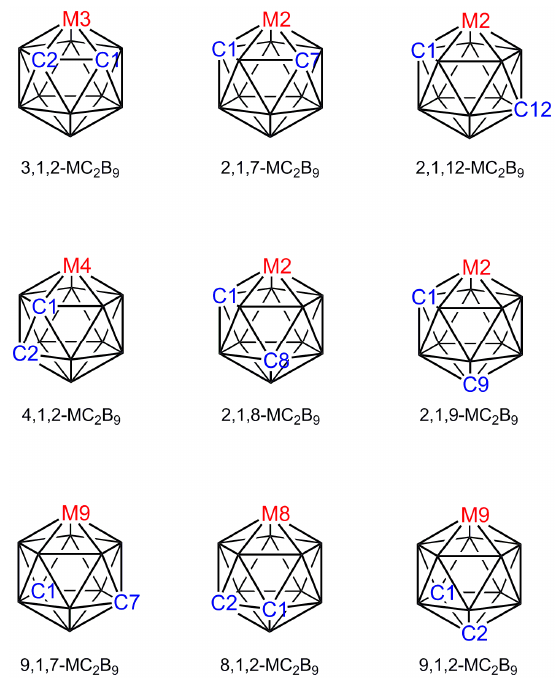
Figure 1. The nine isomers of an icosahedral MC 2 B 9 metallacarborane.